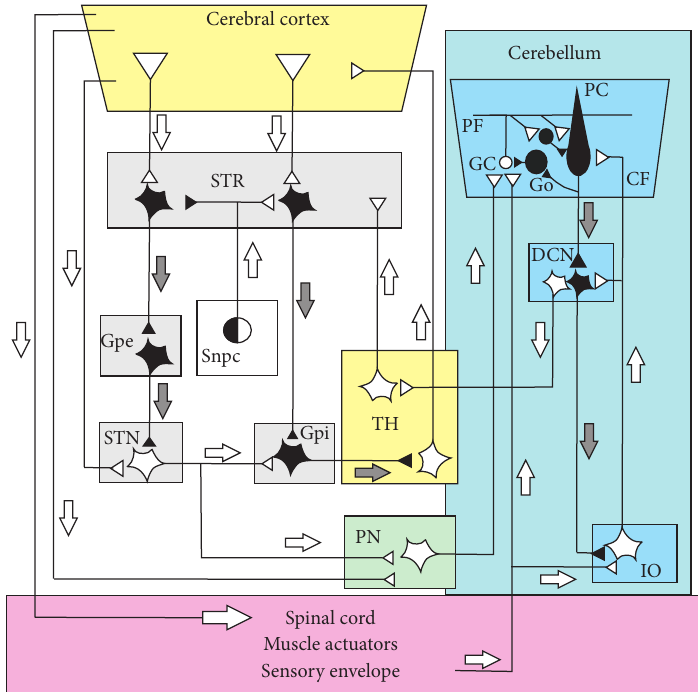
Figure 1: Schematic diagram of the circuits interconnecting the olivocerebellum, the thalamus, the basal ganglia, the pontine nuclei, the cerebral cortex, and the spinal cord. The part of the circuit showing anatomical links between the basal-ganglia and the cerebellum is adapted from recent anatomical experiments using retrograde transneuronal transport of rabies virus from injections into the cerebellar cortex and in nuclei of basal ganglia, establishing evidence for disynaptic pathways that directly link the cerebellum with the basal ganglia (see [1] for a review). Injection of the rabies virus into the cerebellar cortex induced two stages of transport: retrograde transport to first-order neurons in the pontine nuclei (PN) that innervate the injection site and then retrograde transneuronal transport to second-order neurons in the subthalamic nucleus (STN) that innervate the first-order neurons [28]. Injection of rabies virus into the striatum (STR) induced retrograde transport to first-order neurons in the thalamus (TH) that innervate the injection site and then retrograde transneuronal transport to second- order neurons in the dentate nucleus (DN) that innervate the first-order neurons [29]. In addition, the striatal neurons that receive cerebellar inputs include neurons in the “indirect” pathway that send projections to the external globus pallidus (Gpe). The classical network of the basal ganglia ( adapted from [30]) represented by the parallel “direct” and “indirect” pathways from the STR to the basal output nuclei. The “direct” path sent inhibitory input from the SRT to the internal part of the globus pallidus (Gpi). The basal ganglia circuit is completed by the dopaminergic pathway and represented the projection of the substantia nigra pars compacta (Snpc) to the STR. Inhibitory neurons are shown as filled symbols, excitatory neurons by open symbols. Grey and white arrows represent inhibitory or excitatory pathways, respectively. Abbreviations:PC,Purkinjecell;GO,Golgicell;DCN,deepcerebellarnuclei;PF,parallelfiber;GCgranulecell;IO,inferiorolive;CF,climbing